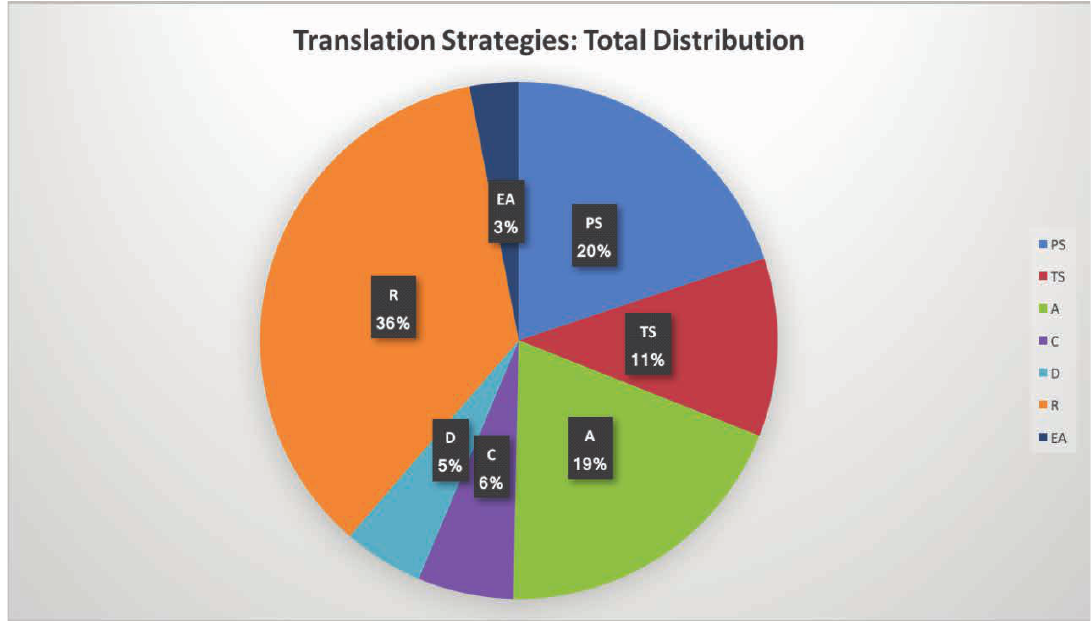
Chart 5: Total distribution of translation